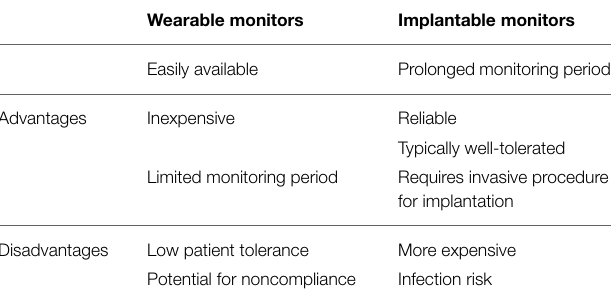
TABLE 2 | Comparison of monitoring devices for atrial